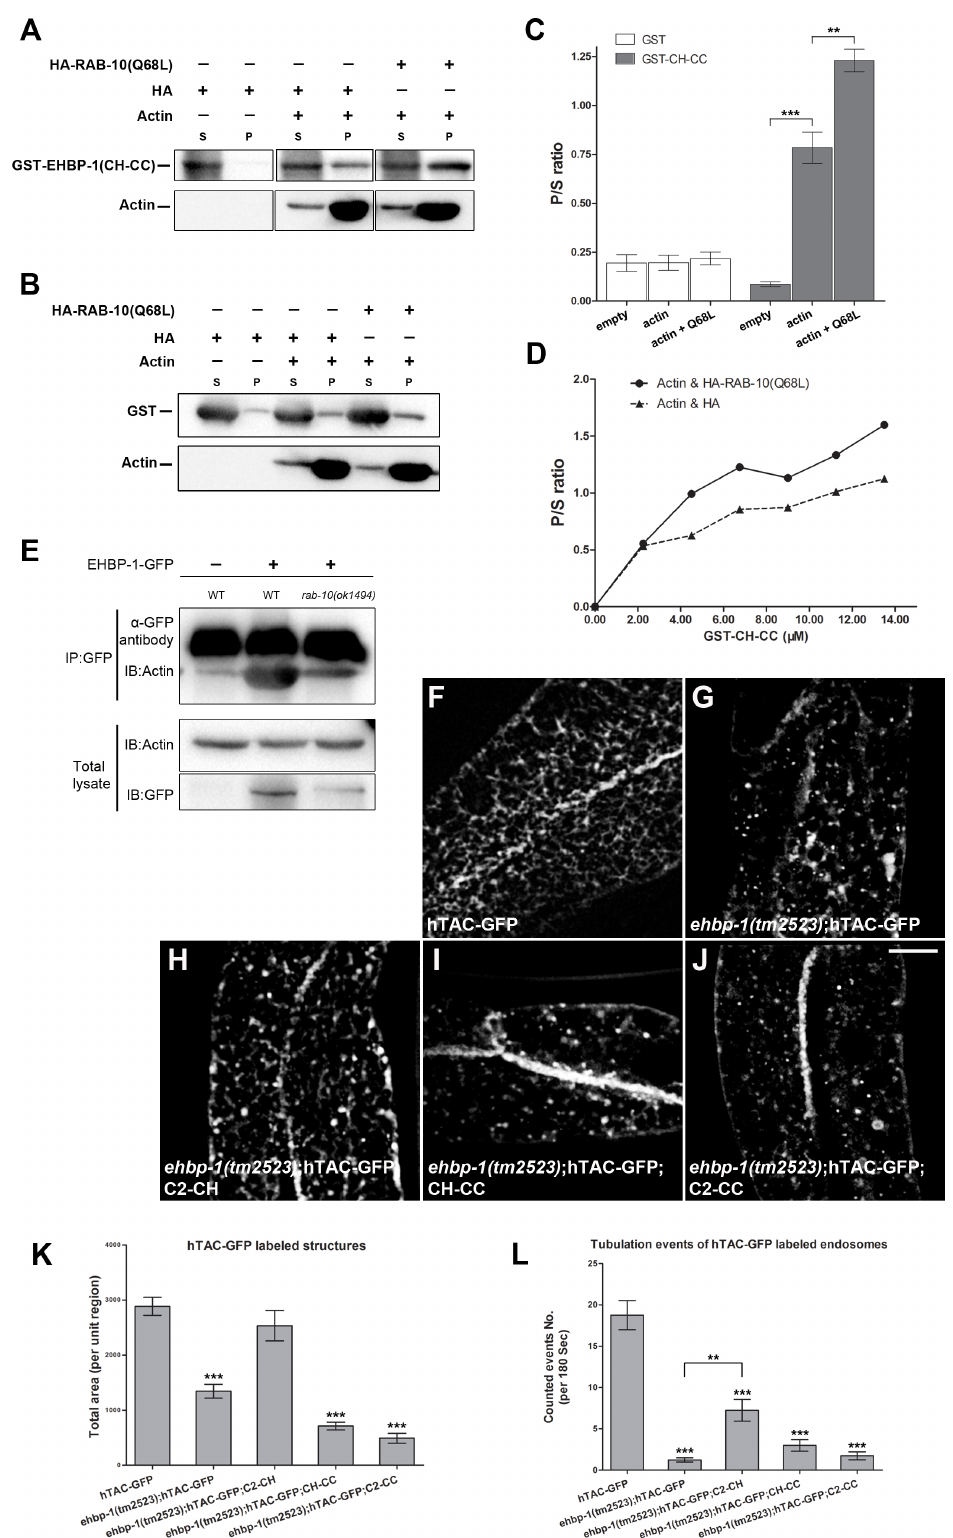
Fig 6. RAB-10(GTP) promotes co-sedimentation of EHBP-1 with F-actin and C2-CH partially restores hTAC-GFP tubular endosomal localization in an ehbp-1(tm2523) mutant background. (A)